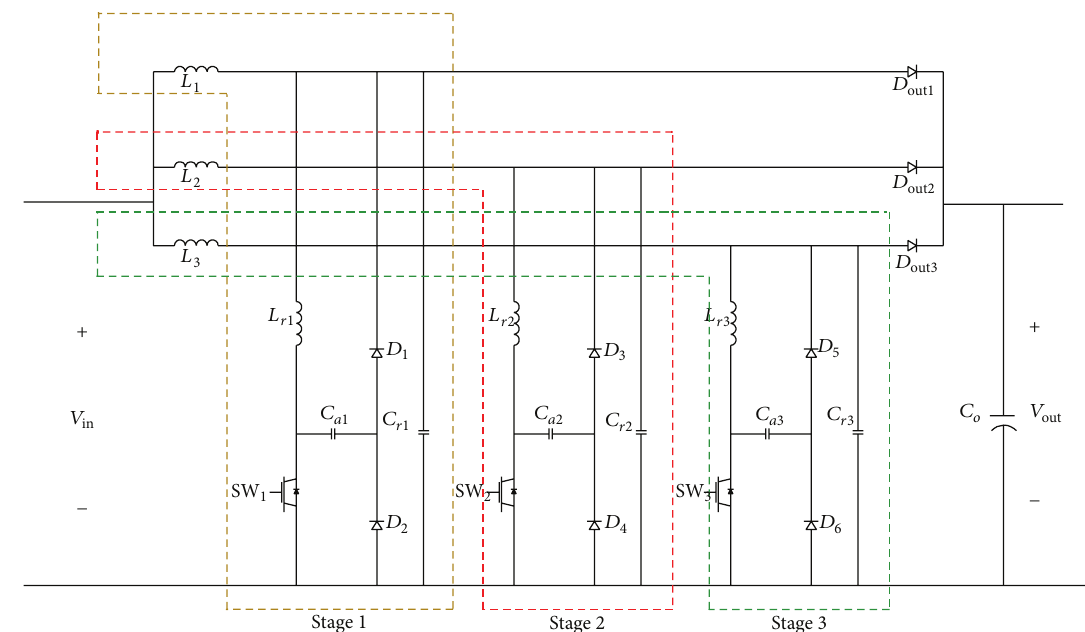
Figure 5: Circuit diagram for three-stage soft-switching boost converter.